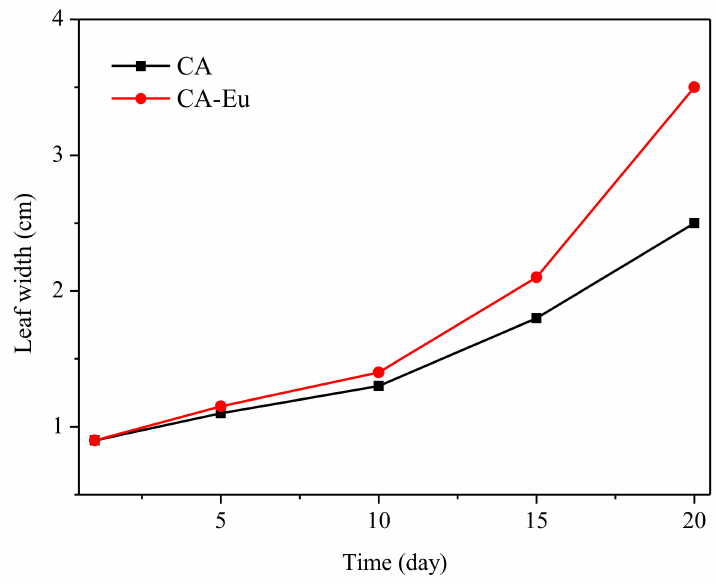
Figure 11. Change of maximum leaf width from day 1 to day